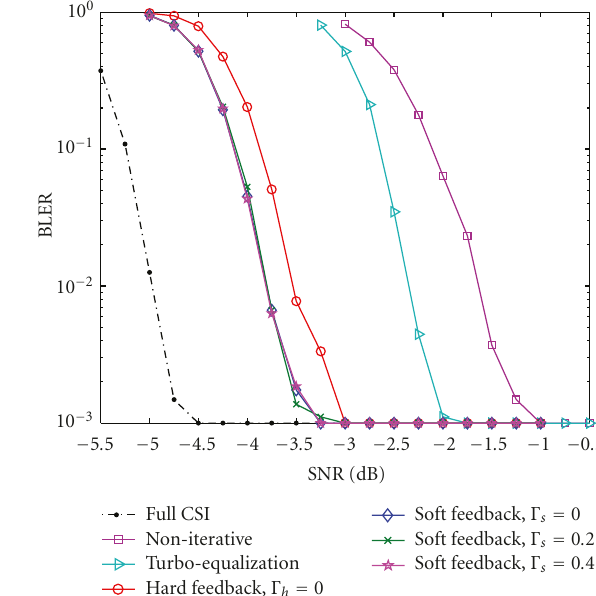
Figure 5: Simulation results, N t = 3, N r = 6, QPSK.